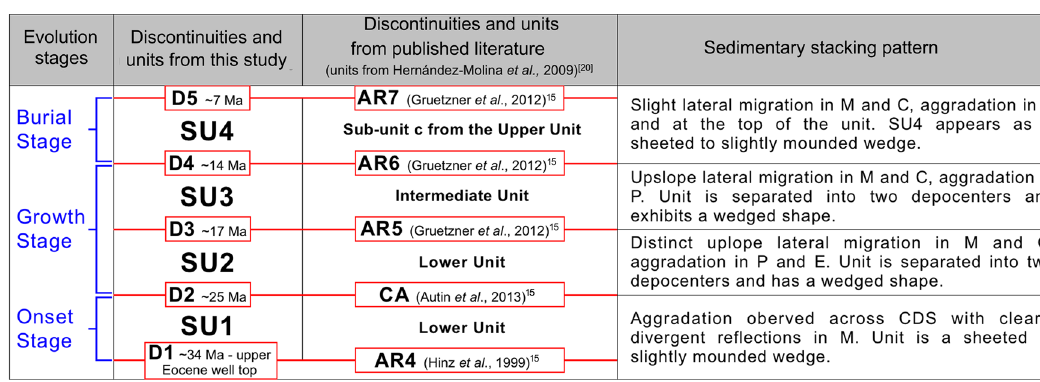
Table 1. Table showing evolutionary stages, the main seismic unit and discontinuities correlated with well formation tops and published records, and a summary of the sedimentary stacking pattern. The table was generated using Pixelmator Pro 2.1.3 Coral (https:// www. pixel mator. com/